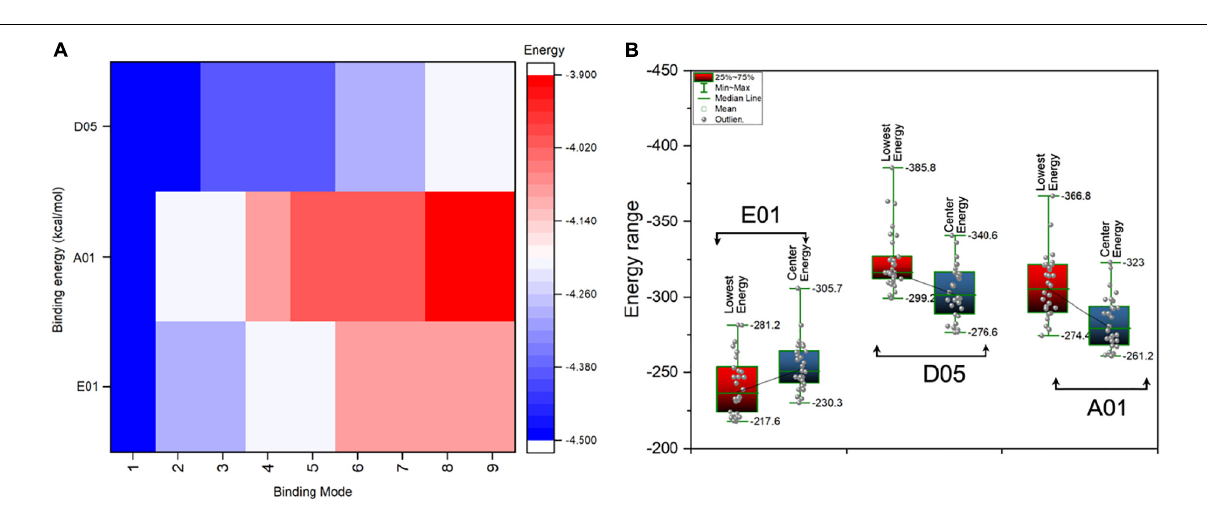
FIGURE 5 | Binding energies (kcal/mol) of single molecule phosphorylcholine (PC) and PC conjugate with cloned antibodies, i.e., E01, A01, and D05. (A) The AutoDock Vina binding energies score of single molecule PC in kcal/mol with various clones (heatmap). The scale bar indicates the highest (indicated in blue) and lowest (indicated in red) in terms of negative score. The negative score indicated the highest binding affinity. (B) The box plot represents the antibody (clone antibodies)-antigen (PC conjugate) binding energies (lowest energies) for various